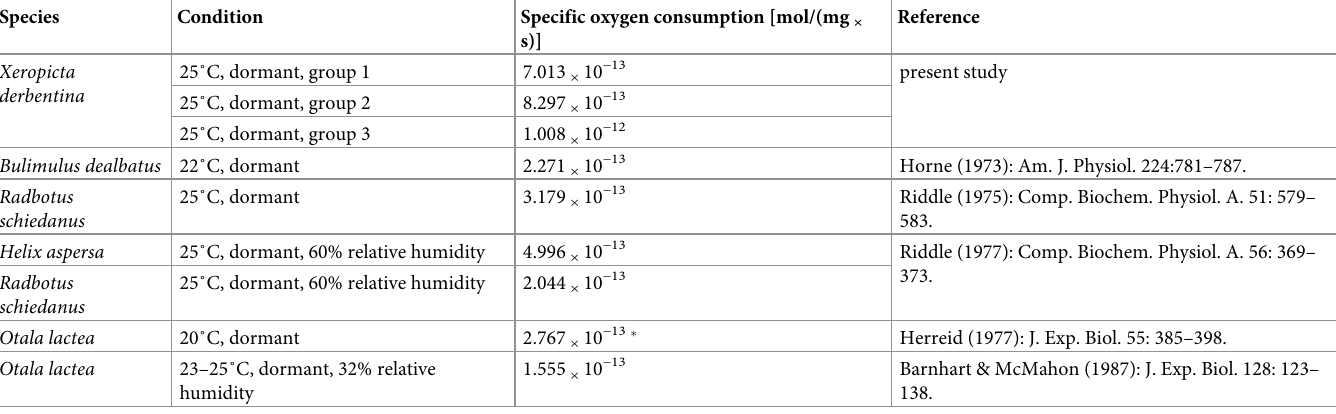
Table 1. Overview of oxygen consumption values for different snail